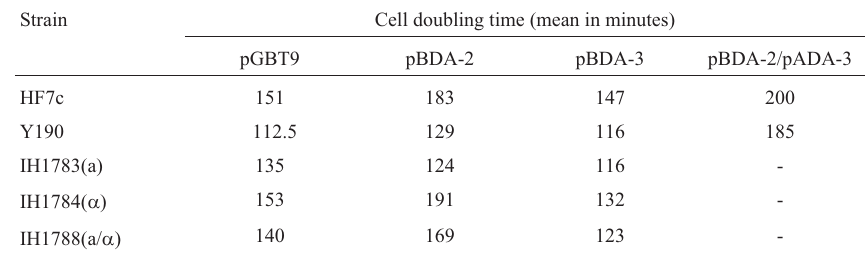
Table 3 - Doubling time of different yeast cells transformed with pGBT9, pBDA-2 and